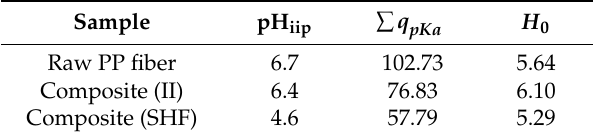
Table 3. Results of determination of acid-base properties of the composites’ sample